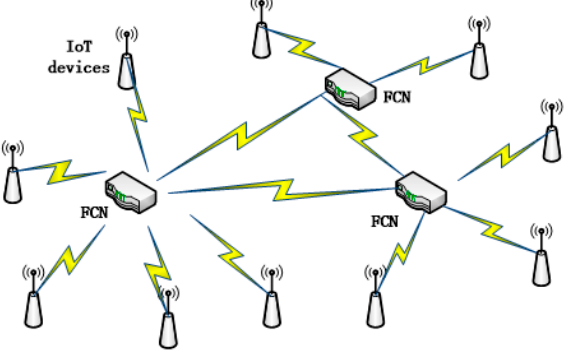
Figure 2. Fog computing nodes and IoT devices nearby.